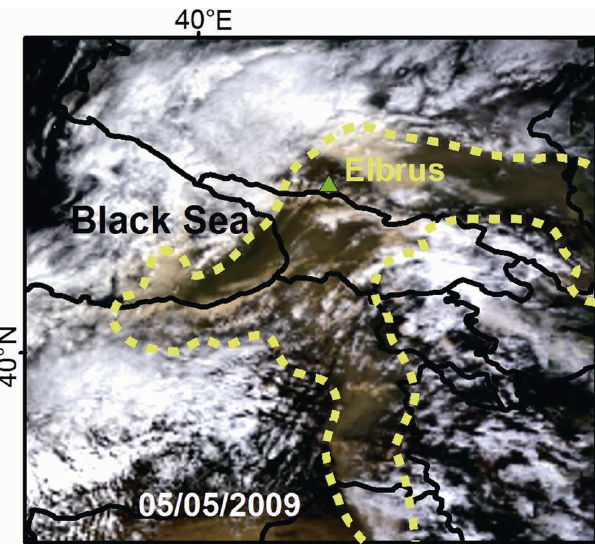
Fig. 5. MODIS surface reflection image showing the dust cloud (brown) over the Caucasus on 5 May